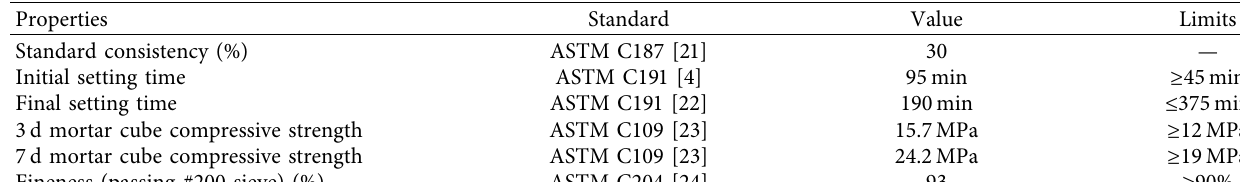
Table 1: Physical properties of